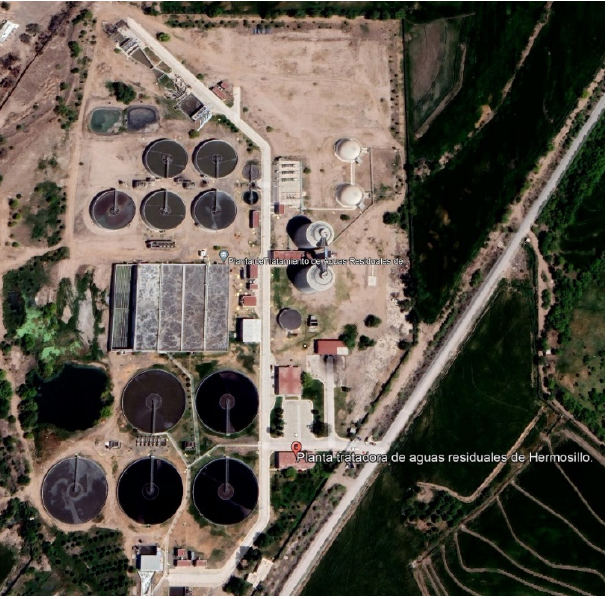
Figure 7. The wastewater treatment plant in Hermosillo, Sonora, Mexico [78].